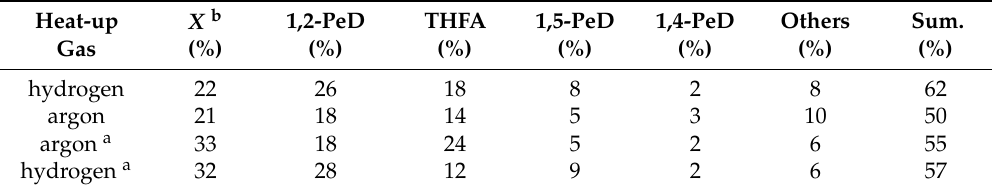
Table 3. Selectivity and conversion under variation of the heat-up procedure.